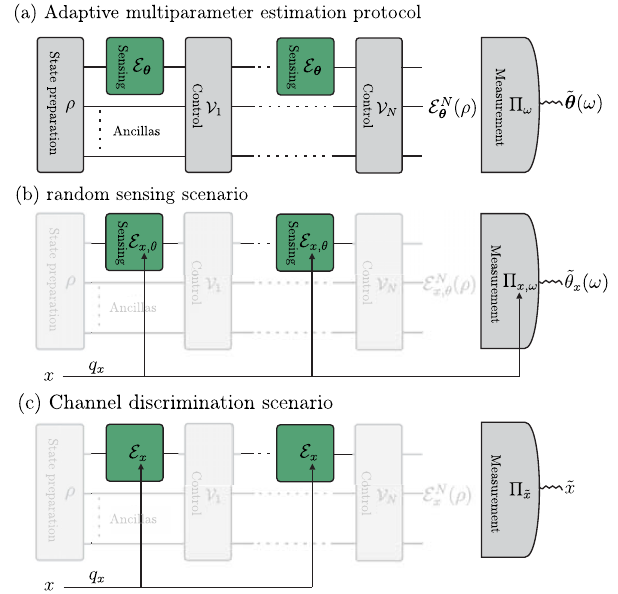
FIG. 2. Schematic representation of the three operational tasks considered in this paper. (a) Estimation of the parameters θ ¼ ð θ 1 ; … ; θ p Þ appearing in the quantum channel E θ under the most general entanglement-assisted adaptive strategy with N uses of the channel. (b) Random quantum sensing, where a single parameter θ is encoded by a channel E x; θ randomly chosen from x is revealed p channels with probability q x , and the extracted only before the measurement stage. (c) Channel discrimination under the most general strategy with N uses of the channel.